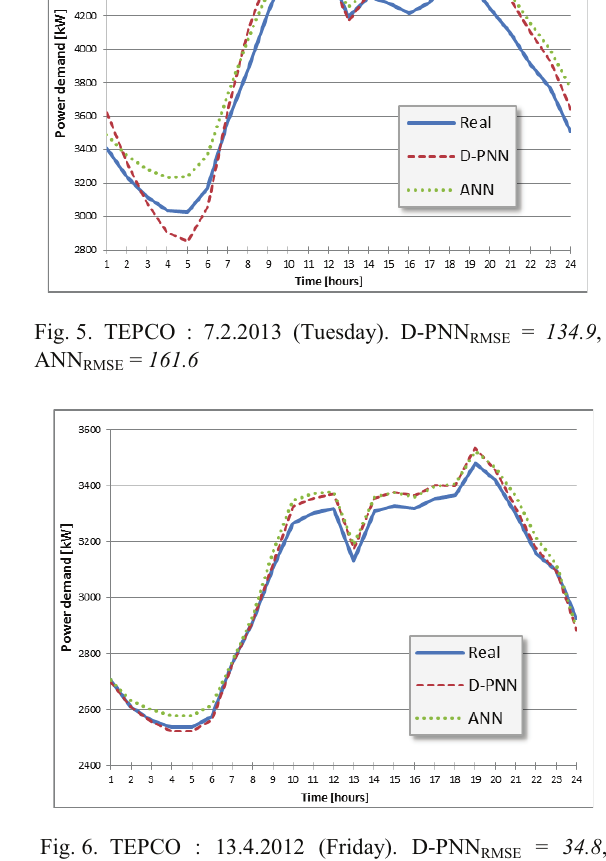
Fig. 6. TEPCO : 13.4.2012 (Friday). D-PNN RMSE = 34.8 , ANN RMSE =